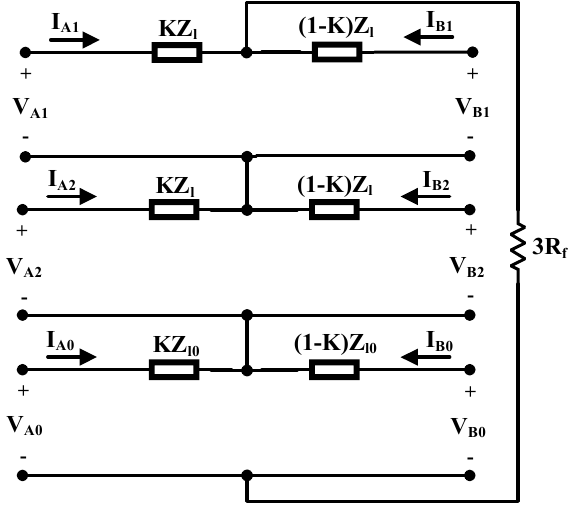
Figure 5. Sequence equivalent circuits for SLG fault.